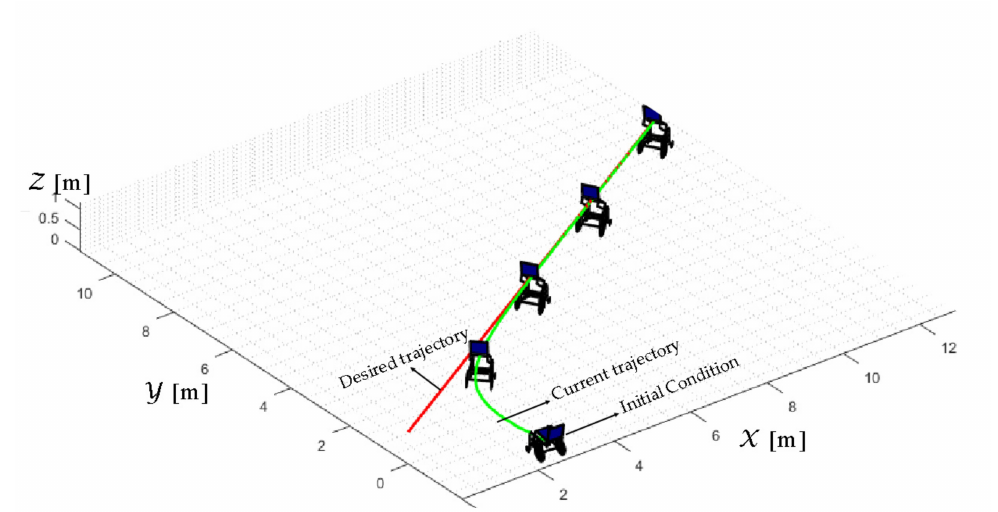
Figure 20. Stroboscopic movement of the human–robot system based on the real experimental data.